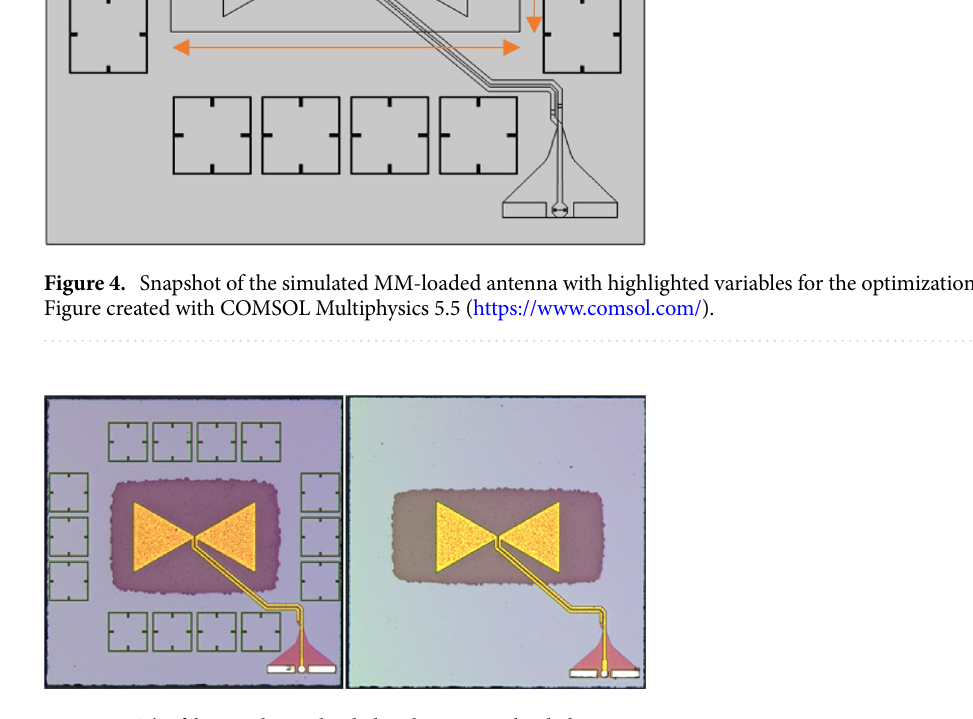
Figure 5. The fabricated MM-loaded and non-MM-loaded